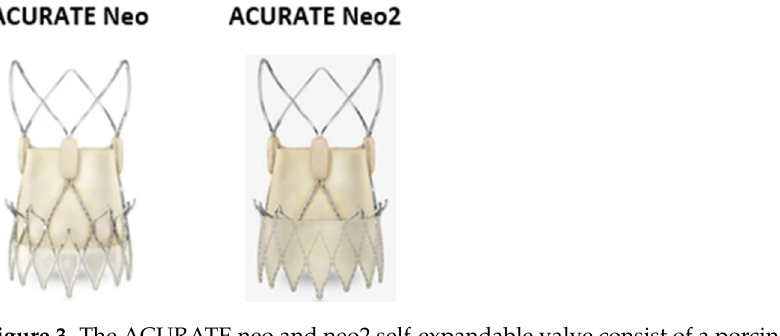
Figure 4. The self-expandable intra-annular Portico and Navitor valve is the only self-expanding valve with intra-annular leaflets and a non-tapered stent which provides uncompromised coronary access. Figure 5. The Myval balloon-expandable valve is made by a nickel-cobalt alloy frame which is cre- ated of a single design element open cell hexagons while the remainder has closed cells with higher annular radial force towards the ventricular end. 2.1. SAPIEN Family BEV The SAPIEN THV (Edwards Lifesciences Corporation, Irvine, CA, USA) was the fam- ily’s first generation THV, consisting of a trileaflet, bovine pericardial tissue valve mounted on stainless-steel frame. The Placement of Aortic Transcatheter Valves (PART- NER) A and B trials studied the SAPIEN THV and proved its efficacy in in-operable or high-risk (HR) patients [6,7]. The PARTNER 2A trial was a large, multicentre trial using the second-generation SAPIEN XT valve in intermediate-risk (IR) patients showing non- inferiority in death or disabling stroke at two years for patients that were treated with the SAPIEN-XT valve versus surgical aortic valve replacement (SAVR) [8].